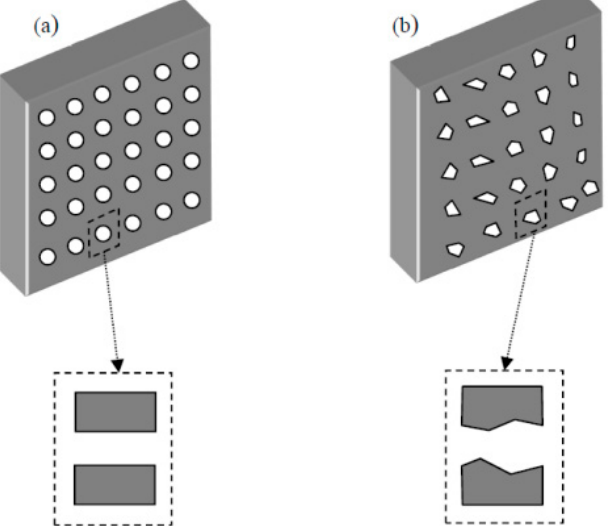
Figure 20. Sketch of an MPP with ( a ) evenly distributed regular size holes and ( b ) irregular holes unevenly distributed.